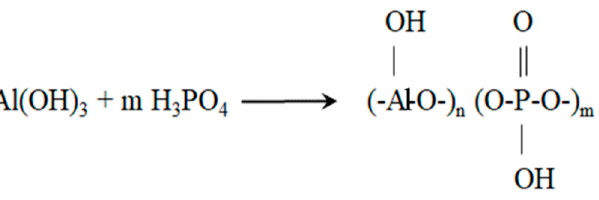
Figure 1. The scheme of synthesis of aluminophosphate oligomers by the reaction of aluminum hydroxide with phosphoric acid.